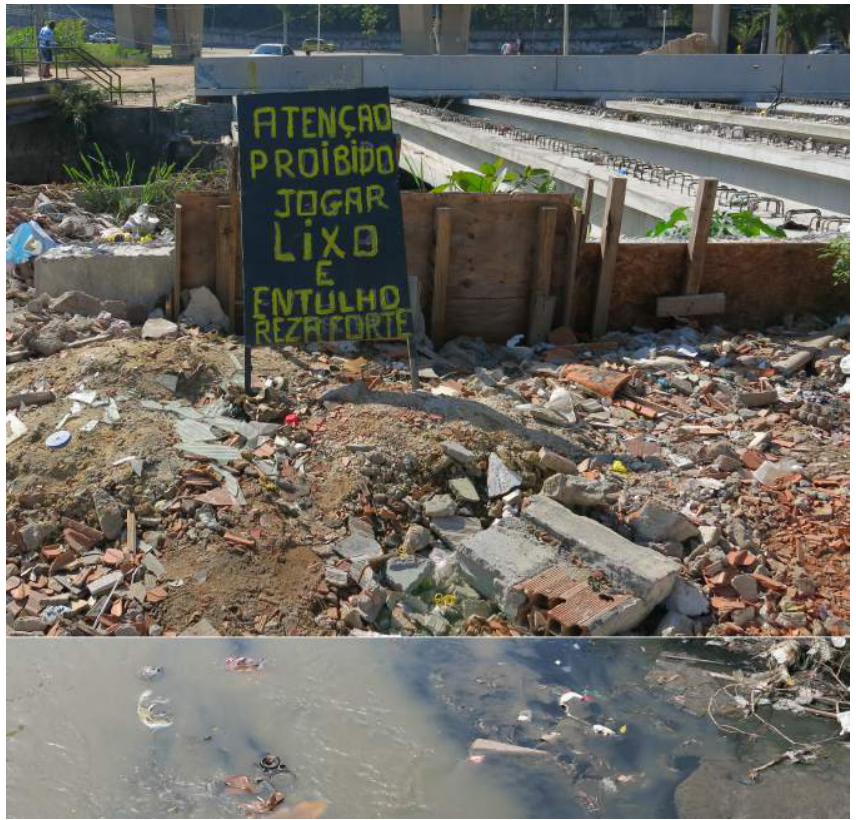
Figure 7. Stalled sewerage project and water of the Faria-Timb´o River,